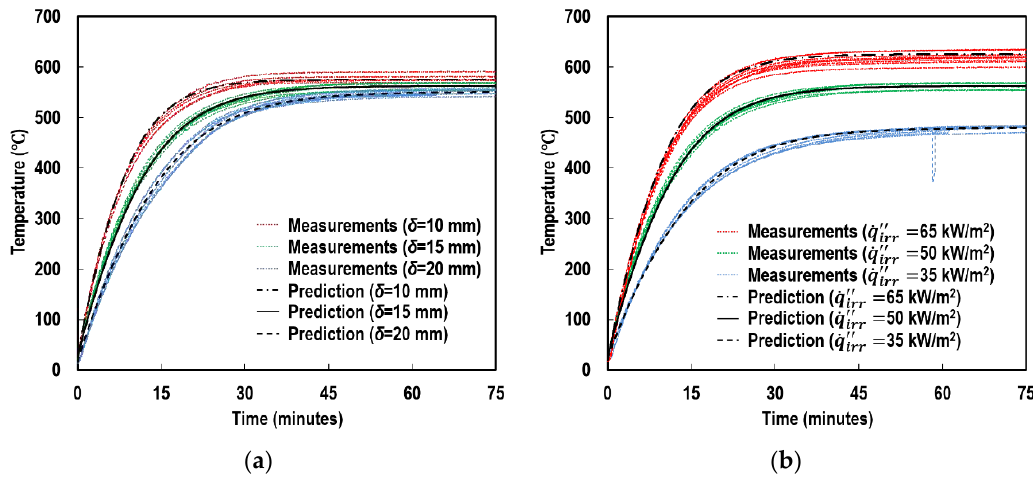
Figure 11. Variations in standard error according to the alteration of absorptivity at ( a ) 𝑞̇ 𝑖𝑟𝑟′′ = 50 kW/m 2 and ( b ) δ = 15 mm.